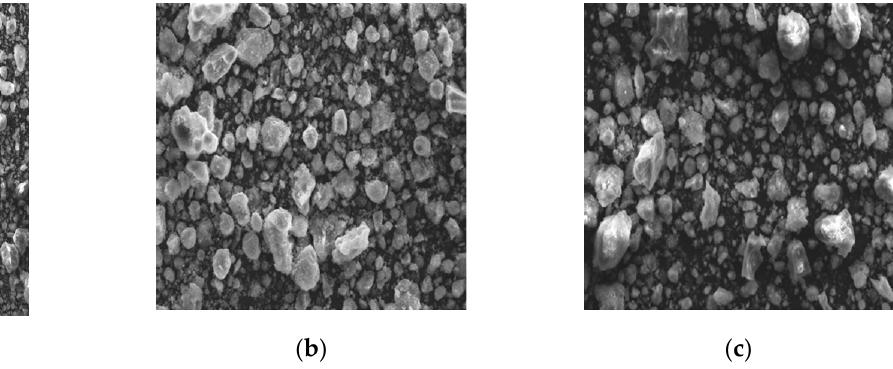
Figure 18. SEM images of AAC specimens: ( a ) CAAC-C, ( b ) CAAC-F, ( c ) GGBS-CE-AAC-F.